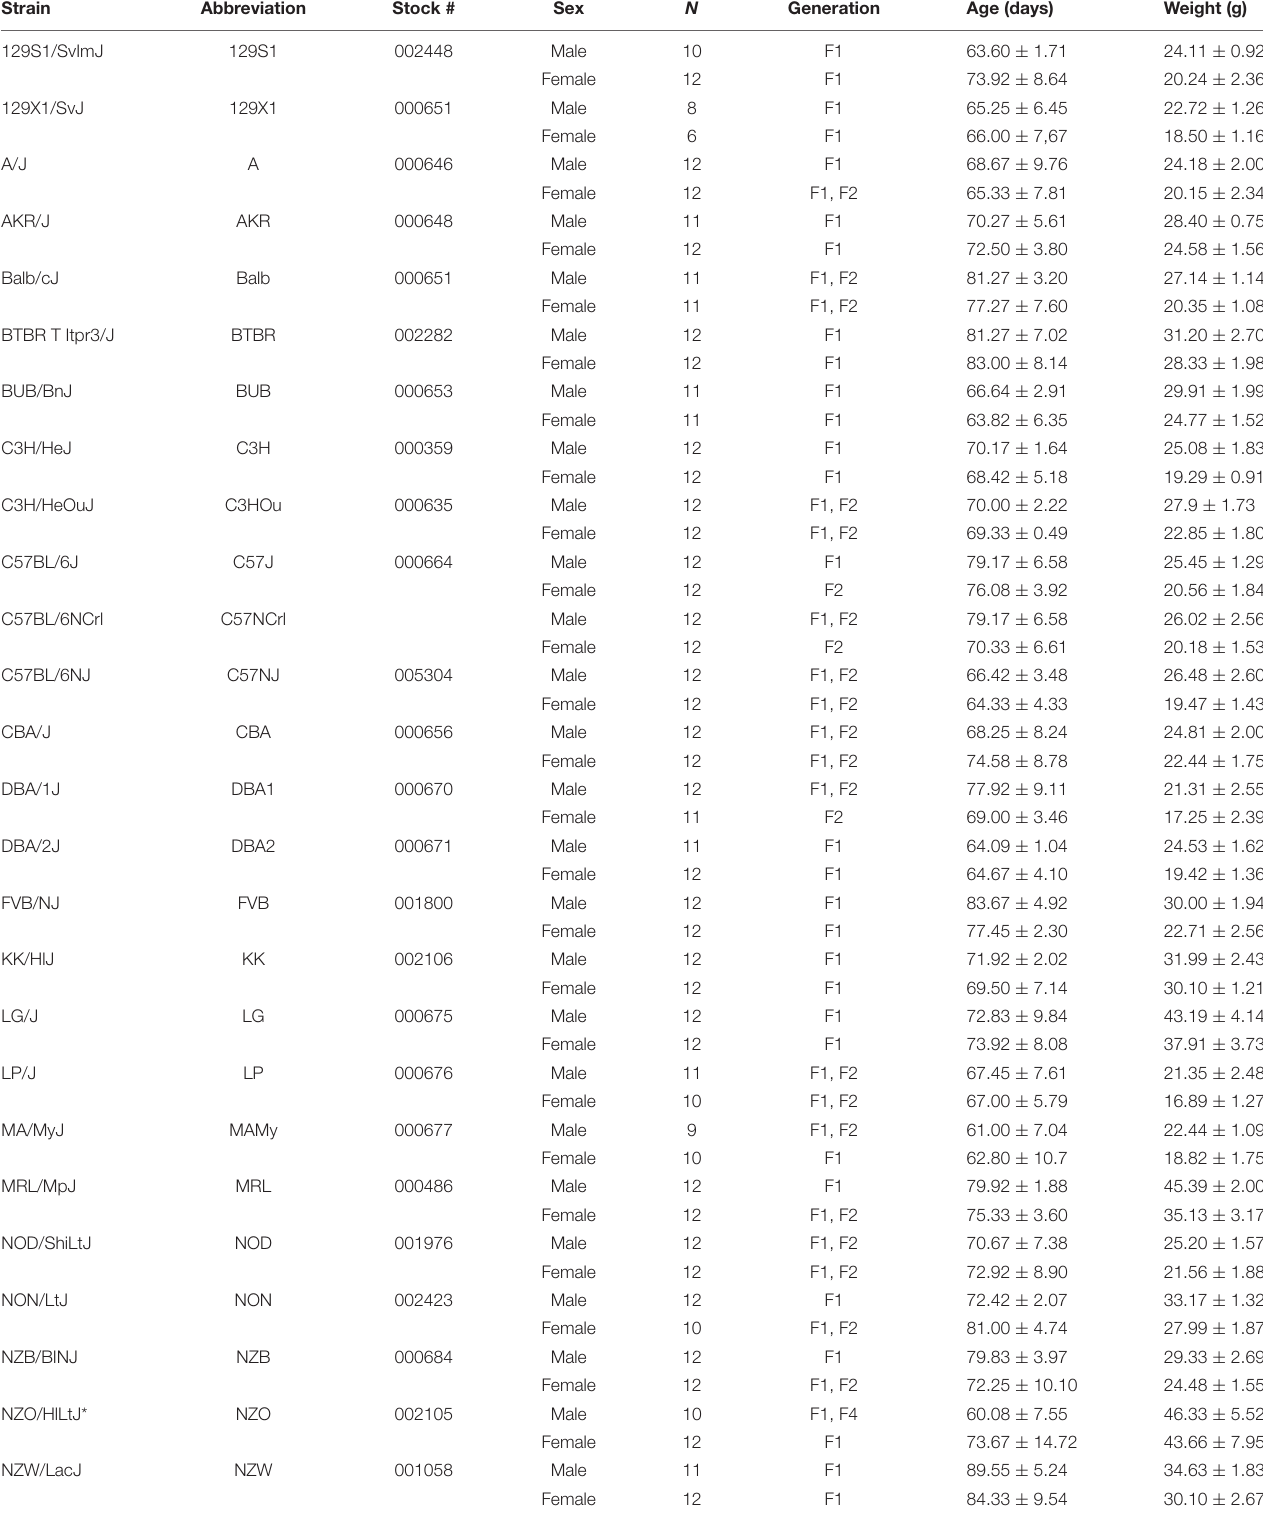
TABLE 1 | Thirty inbred strains were screened in metabolic